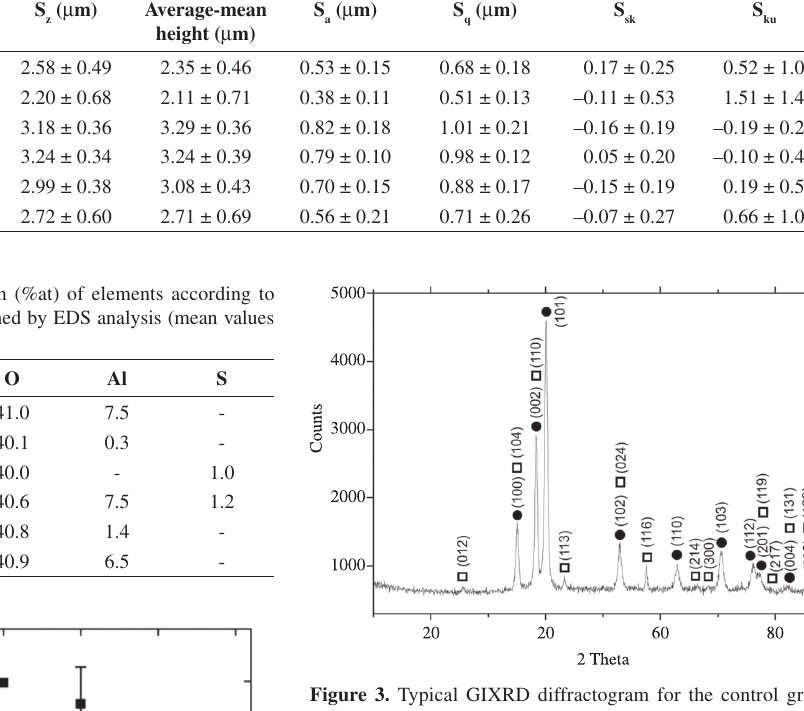
Table 2. Mean values (±SD) of tridimensional roughness parameters as determined by AFM (scanning area of 50 × 50 µ m 2 ). Group S ( µ m) y